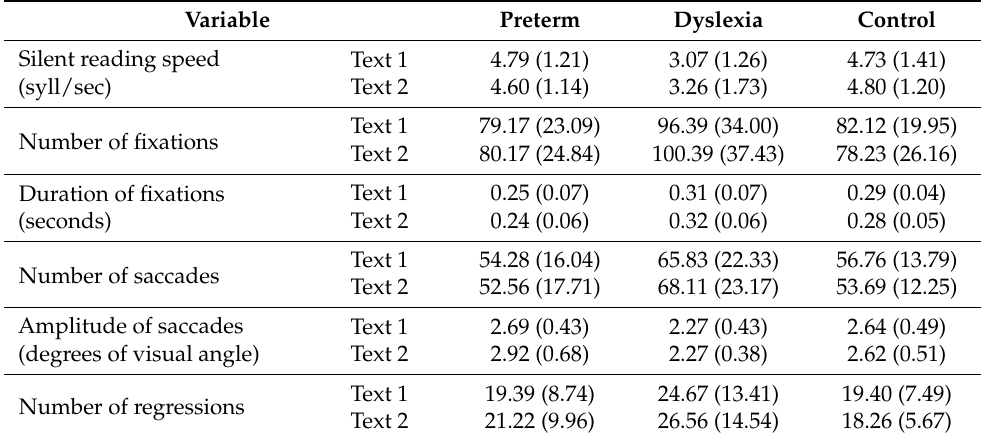
Table 2. Means and Standard Deviations for the Eye-movement